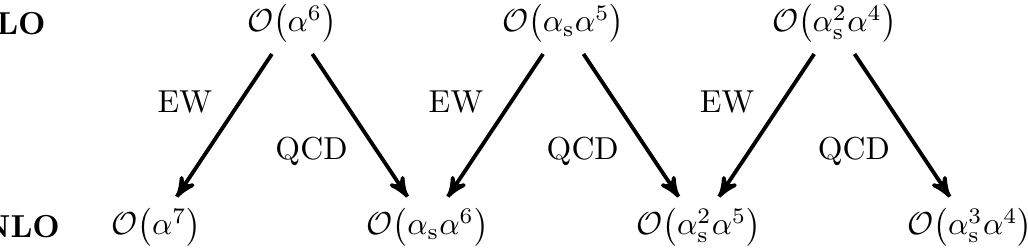
Figure 2. All contributing orders at both LO and NLO for the process pp